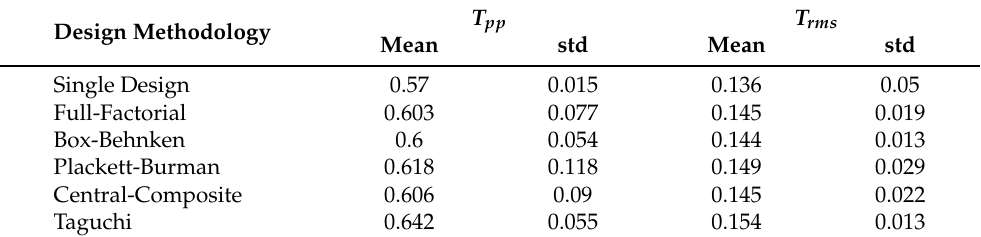
Table 3. The resulting mean value and the standard deviation of the peak to peak ( T pp ) and rms cogging torque T rms after the different Design of Experiment